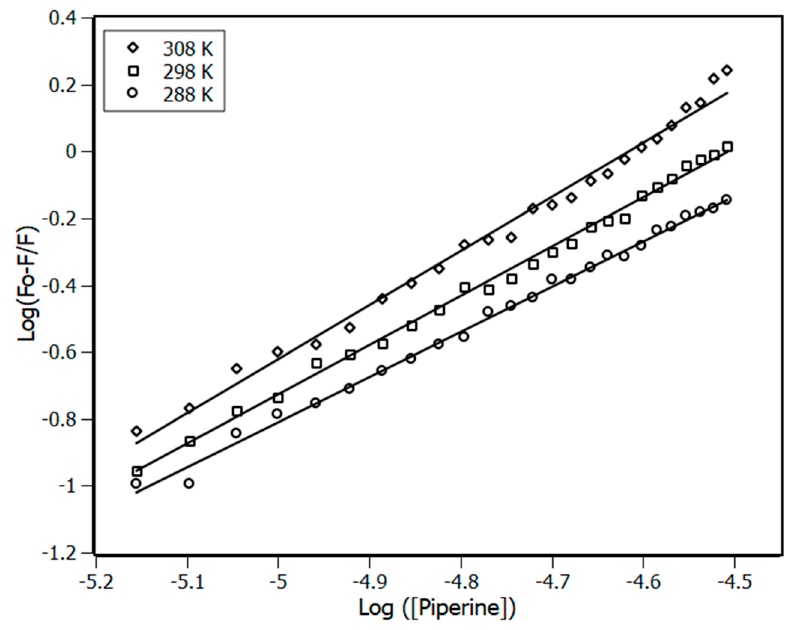
Figure 3. Double-log plots for the fluorescence quenching of NBD (4 μ M) in the presence of piperine at 288 K, 298 K and 308 K. R 2 > 0.99.